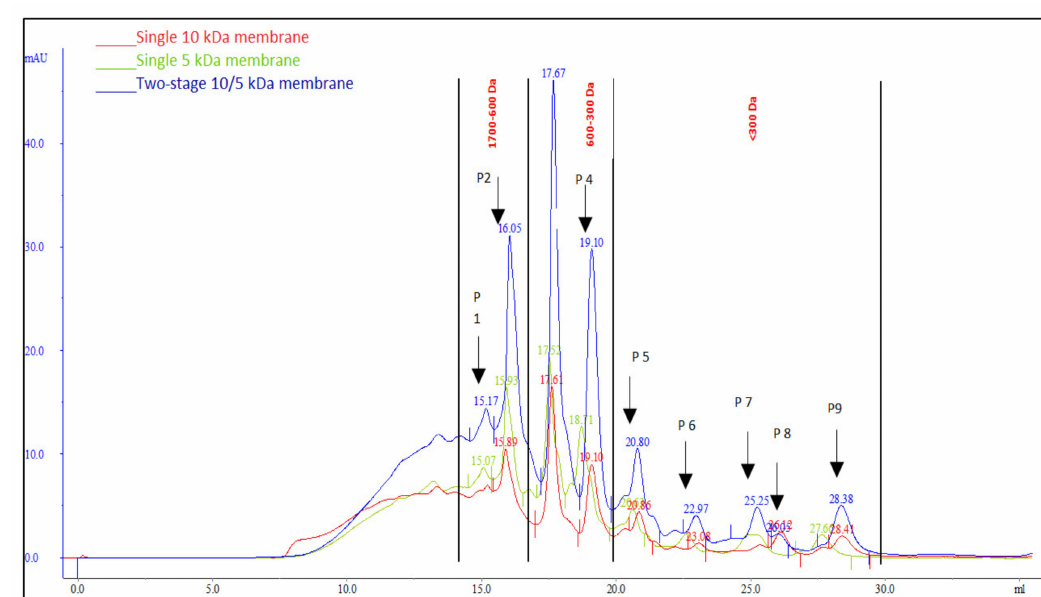
Figure 12. FPLC chromatogram of microalgae protein hydrolysate after fractionation using ultrafiltration membrane for single (10 and 5 kDa membrane) and two-stage 10/5 kDa membranes at a wavelength of 734